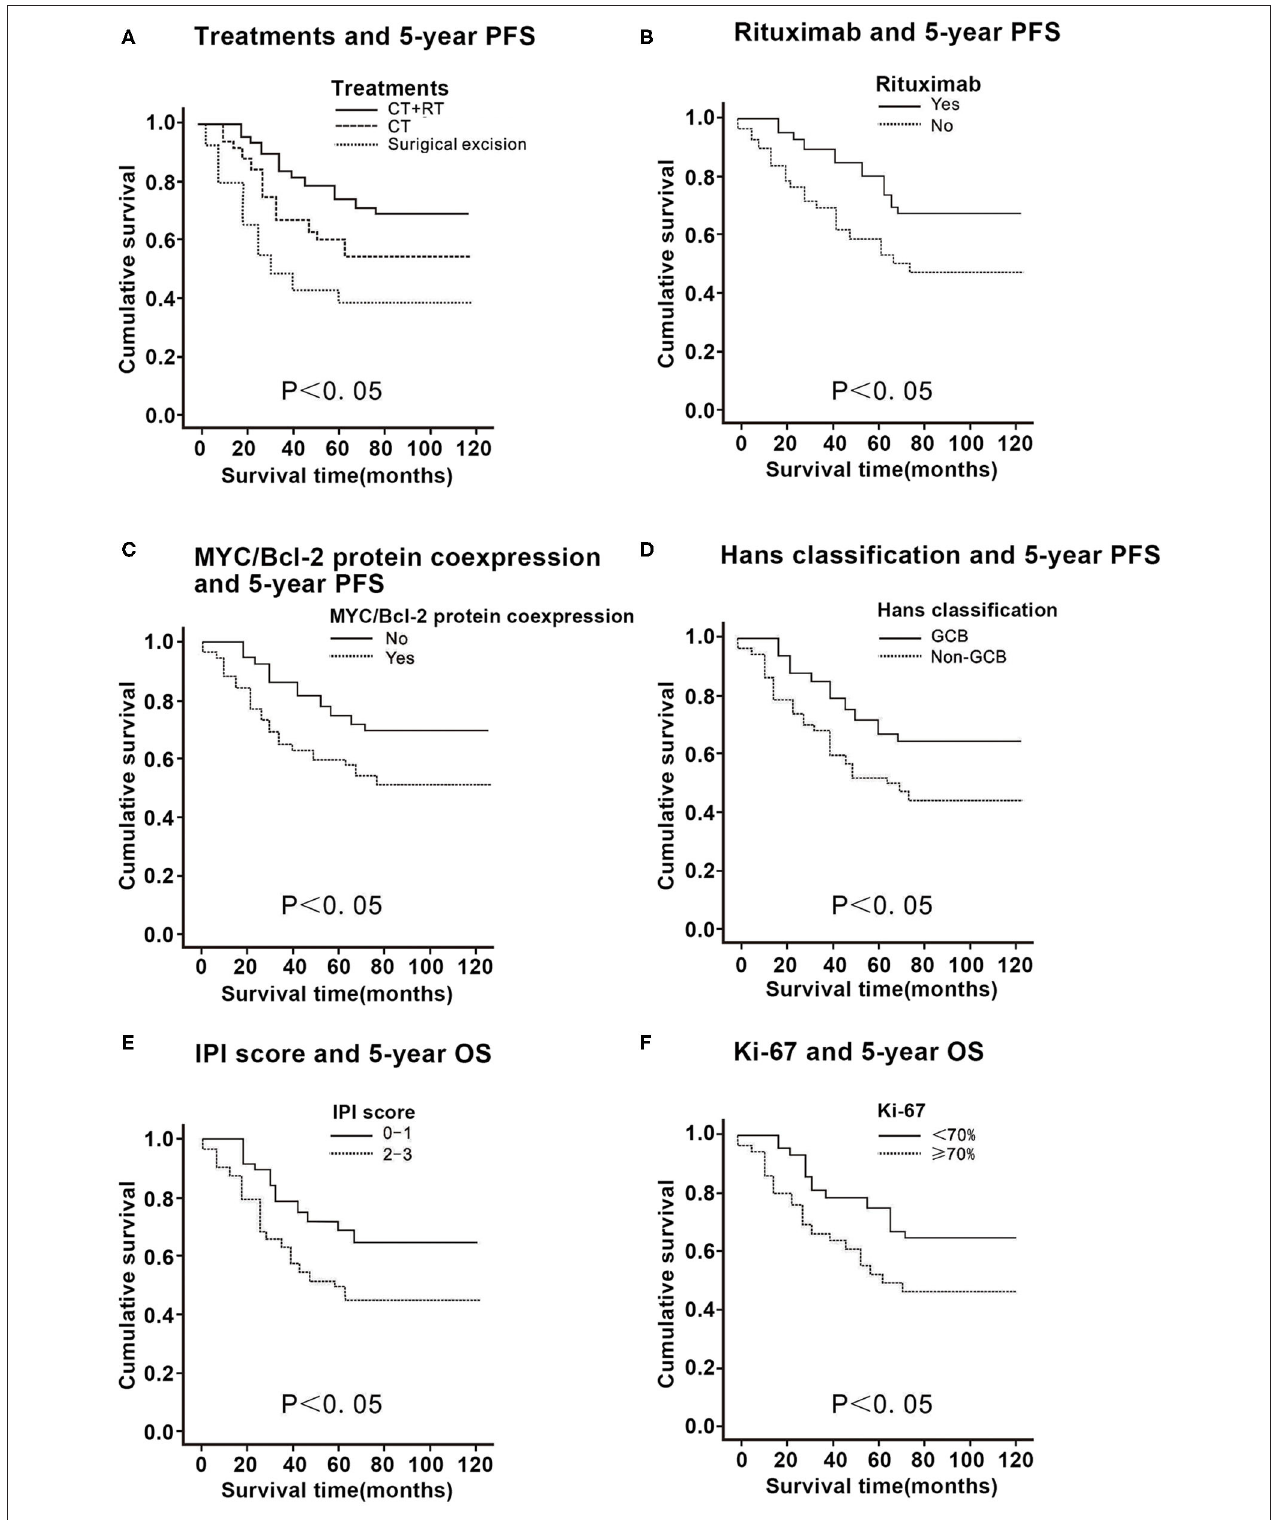
FIGURE 2 | Correlation of the 5-year progression-free survival (PFS) with the clinicopathological features in 58 patients with primary thyroid diffuse large B cell lymphoma. (A) Comparison of the 5-year PFS in patients with primary thyroid DLBCL according to treatments. (B) Comparison of the 5-year PFS in patients with primary thyroid DLBCL according to rituximab. (C) Comparison of the 5-year PFS in patients with primary thyroid DLBCL according to Myc/Bcl-2 protein